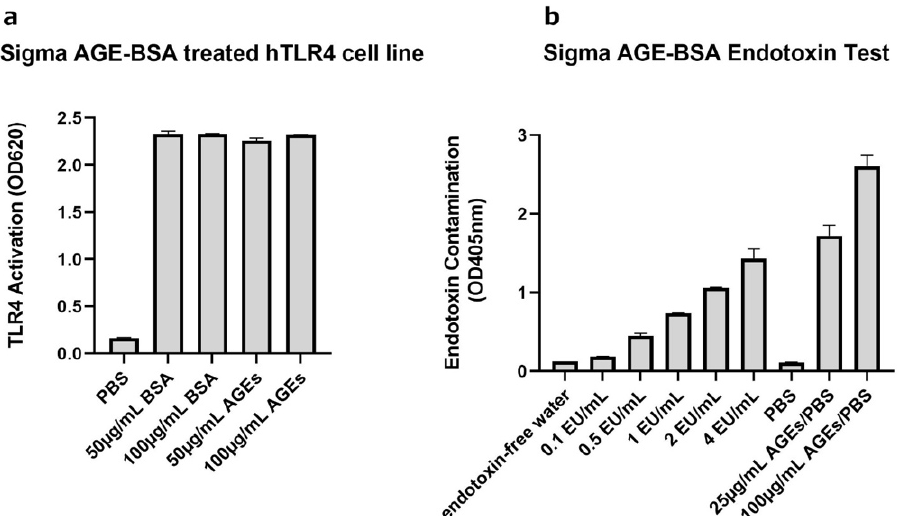
Figure 1 . Sigma AGE-BSA Showed Contamination with TLR-Activating Endotoxin. ( a ) The TLR4 reporter cell line HEK-Blue hTLR4 was incubated with Sigma BSA or Sigma AGE-BSA at the indi- cated concentrations and TLR4 activation measured as a change in absorbance at 620 nm after 24 h. ( b ) Endotoxin contaminating the Sigma AGE-BSA was determined using a Pierce Chromogenic Endo- toxin Quant Kit, according to the manufacturer’s directions. Shown are representative experiments performed in duplicate.